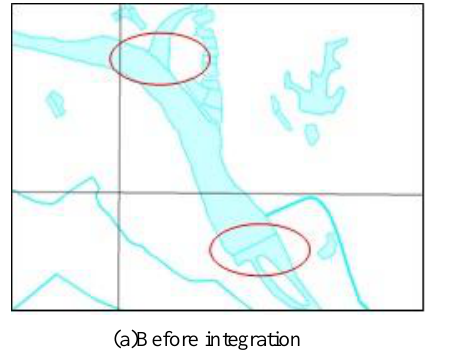
Fig.11 feature-level organization data model of layers Experiment of feature-level of water, is mainly in the person of symbol integration. The data model set symbol integration to polygon features in water area layer, except lakes and ponds. As shown in Fig.12, rivers consist of different polygons merge at intersect. After the integration the edge shared by neighbor polygons disappeared.